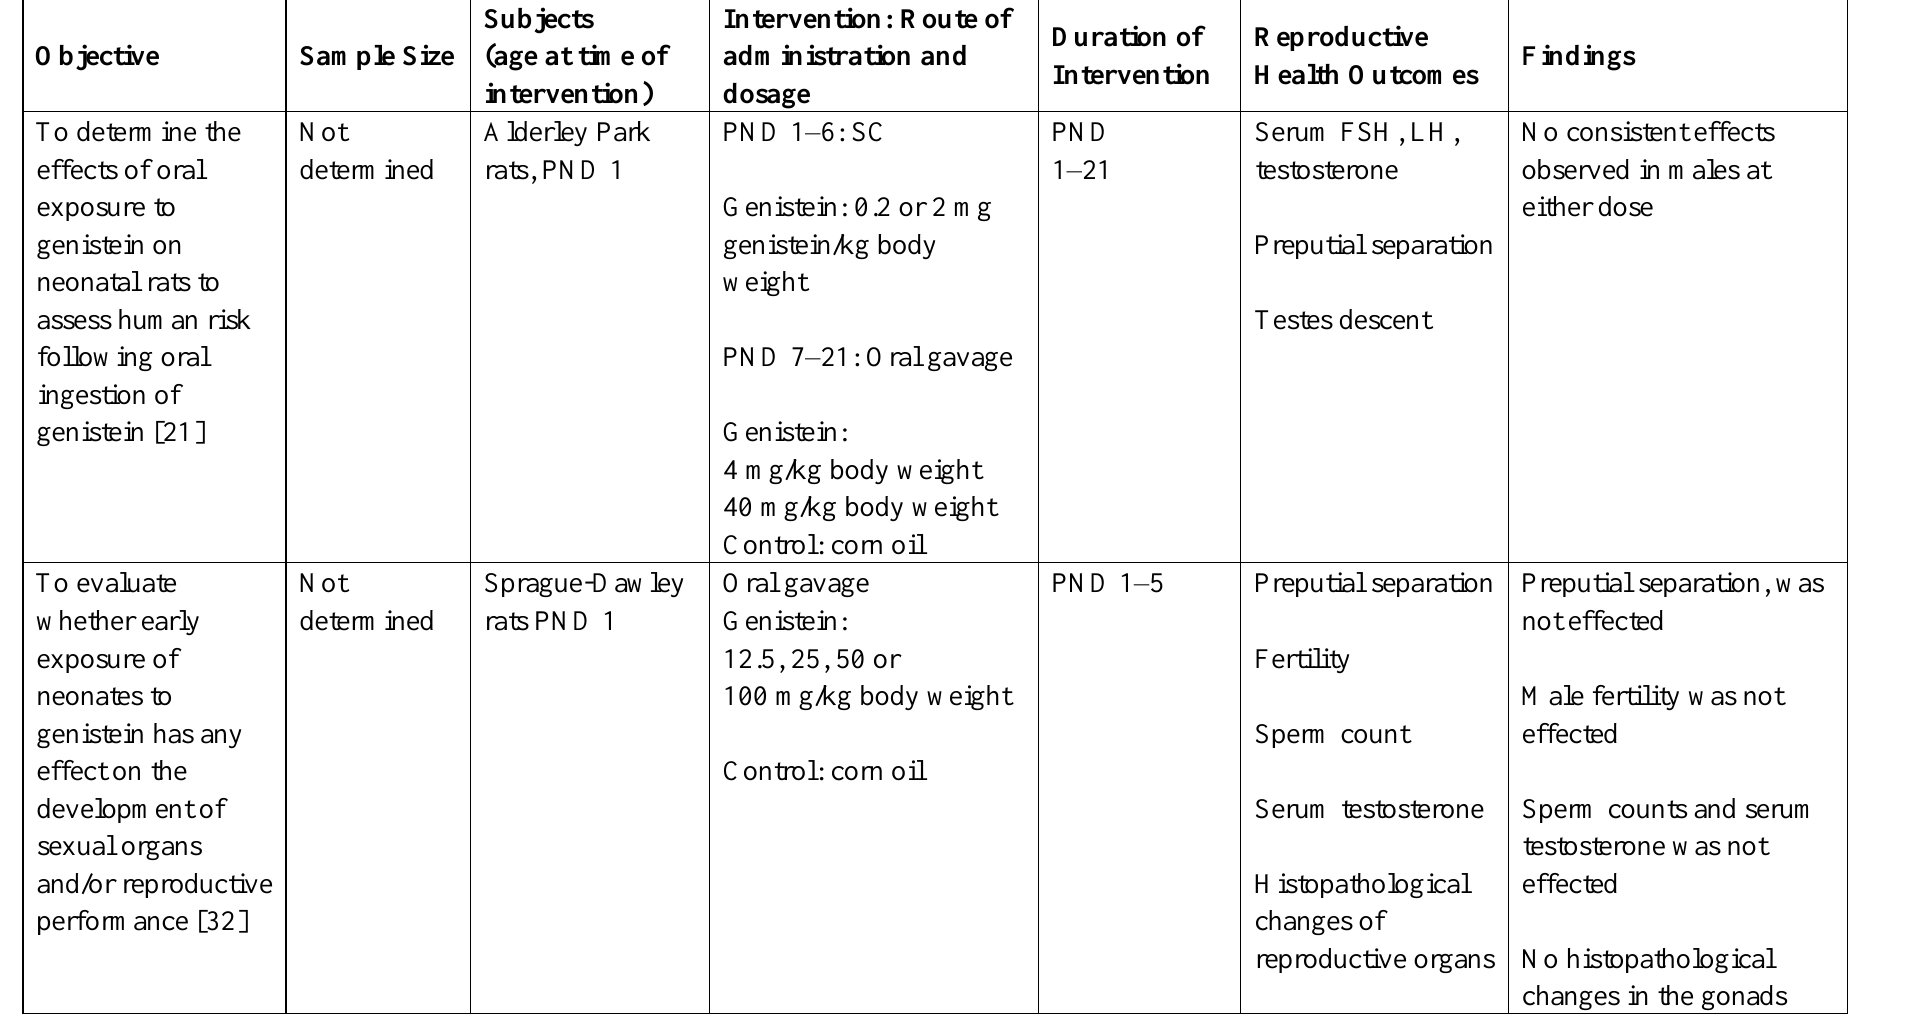
Table 6. Studies in male animals examining the effects of soy isoflavone exposure during early